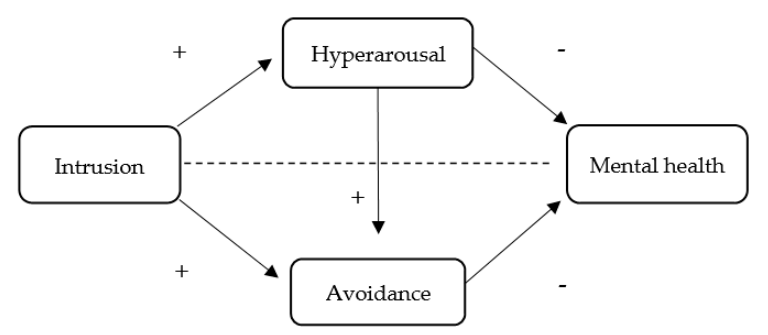
Figure 2. Sequential mediation model proposed to test the associations between intrusive thoughts, hyperarousal, avoidance, and mental health (Study 2). +: positive relationship; − : nega- tive relationship